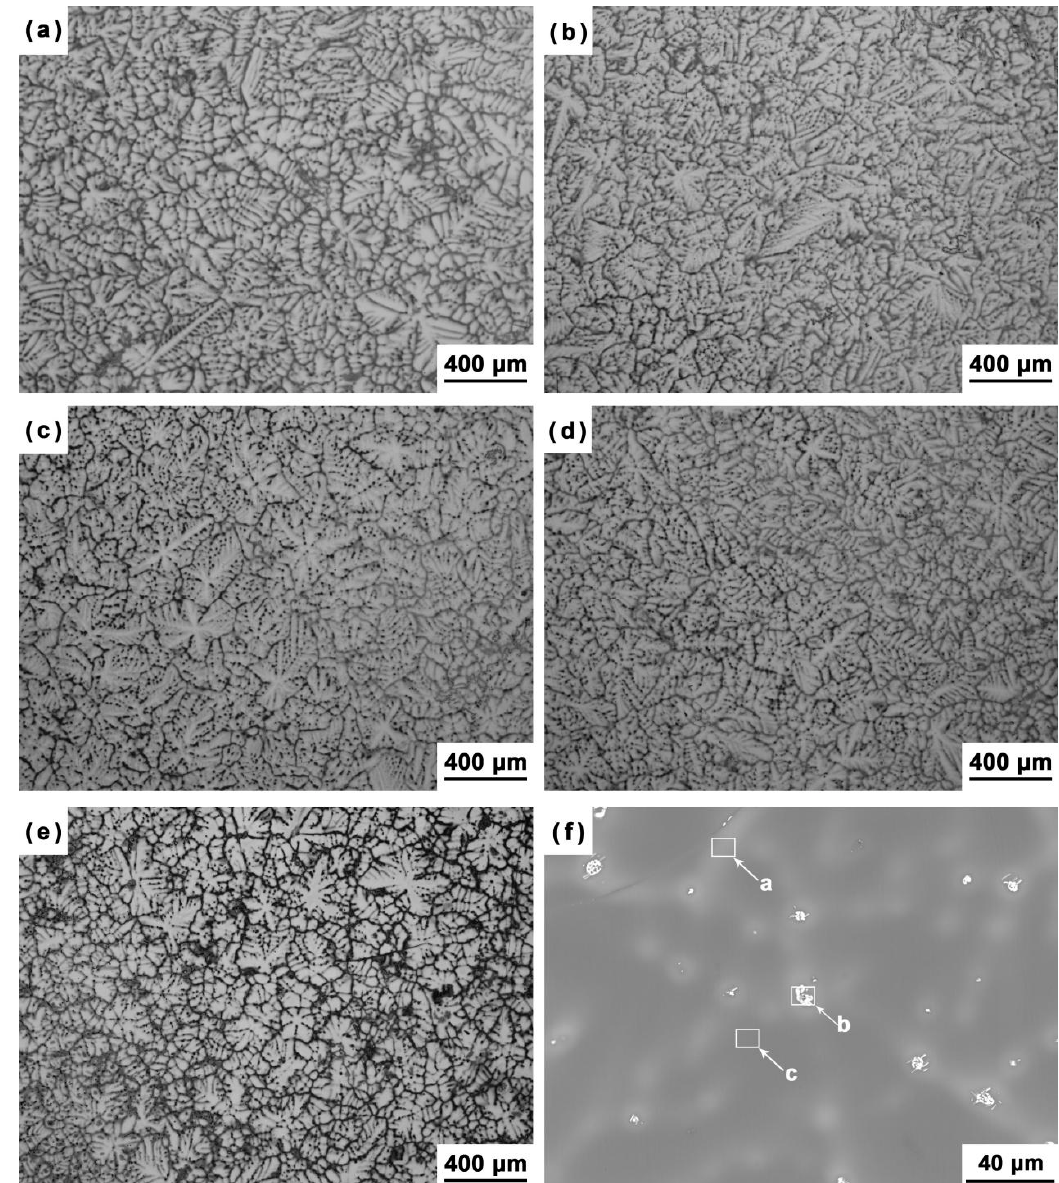
Figure Figure 1. OM micrographs of the Mg–5Sn– x Ga alloys: ( a ) Mg–5Sn, ( b ) Mg–5Sn–0.5Ga, ( c ) Mg–5Sn–